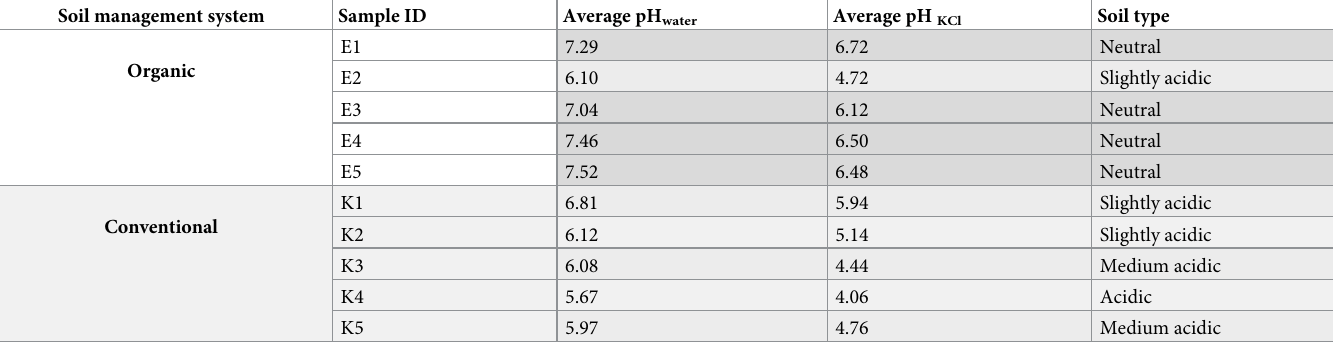
Table 1. pH values of soils from covnventional and organic farming systems, determined in water and potassium chloride.